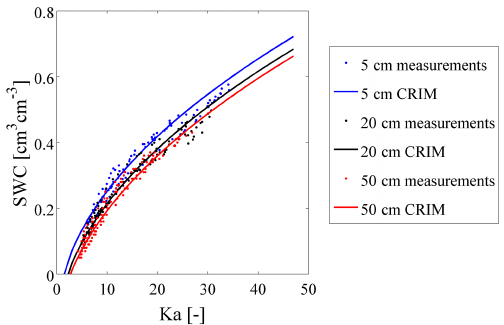
Figure 3. Relationship between dielectric permittivity and soil wa- ter content for the Rollesbroich test site and the derived K a - θ mod- els